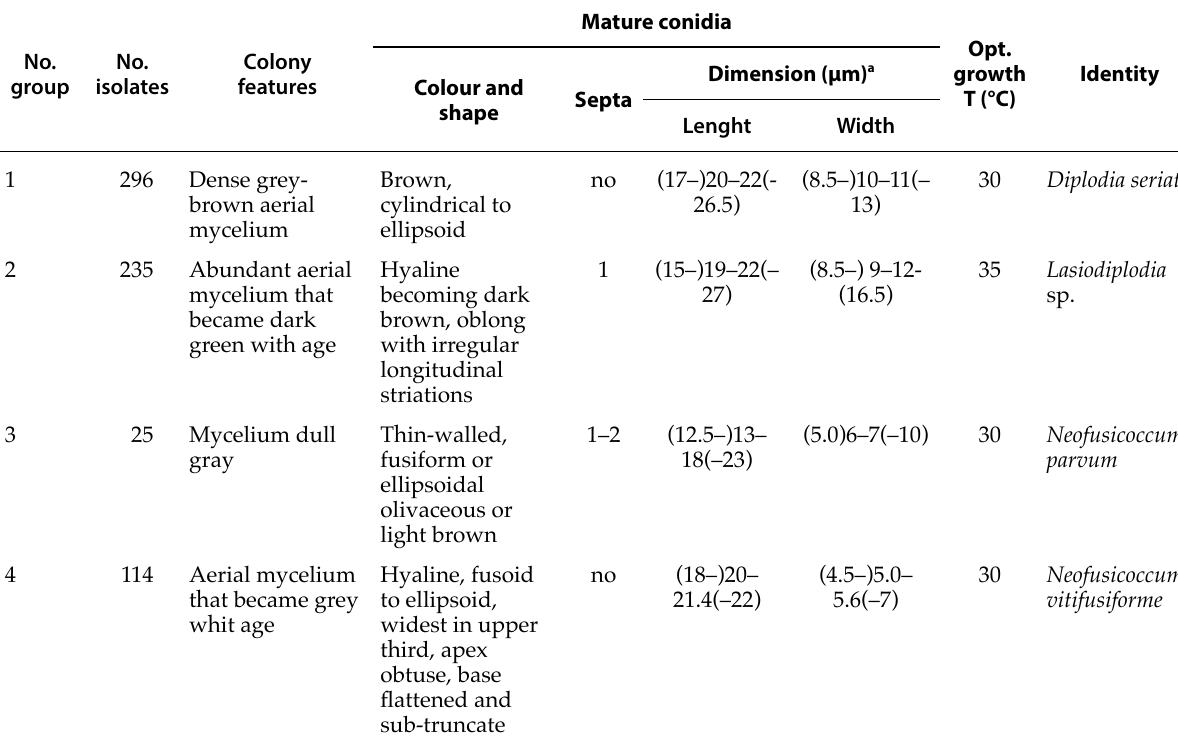
Table 2. Morphological features of the four groups of Botryosphaeriaceae isolated in this study.